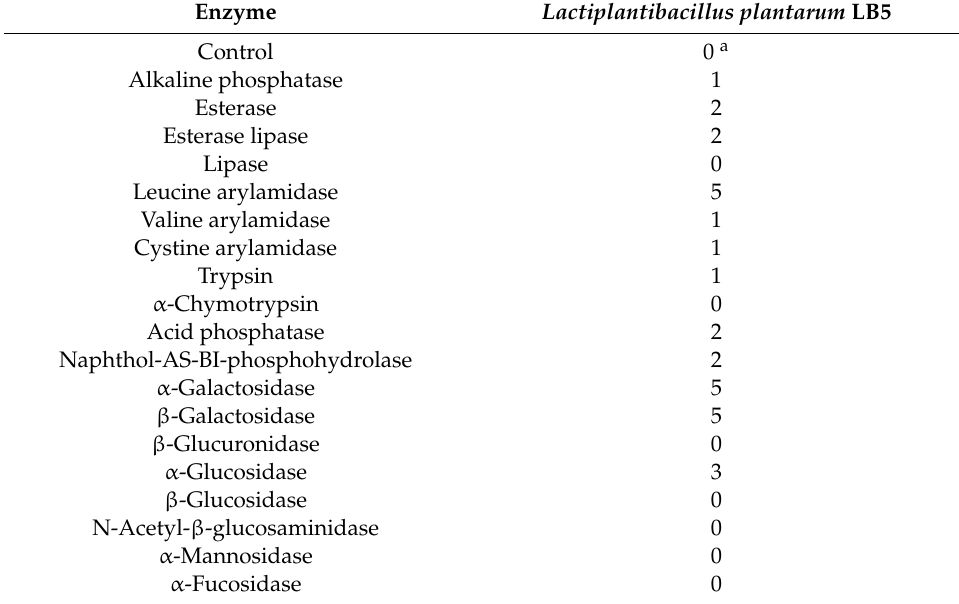
Table 3. Quantification of enzymatic activity of LPLB5 using the API ZYM